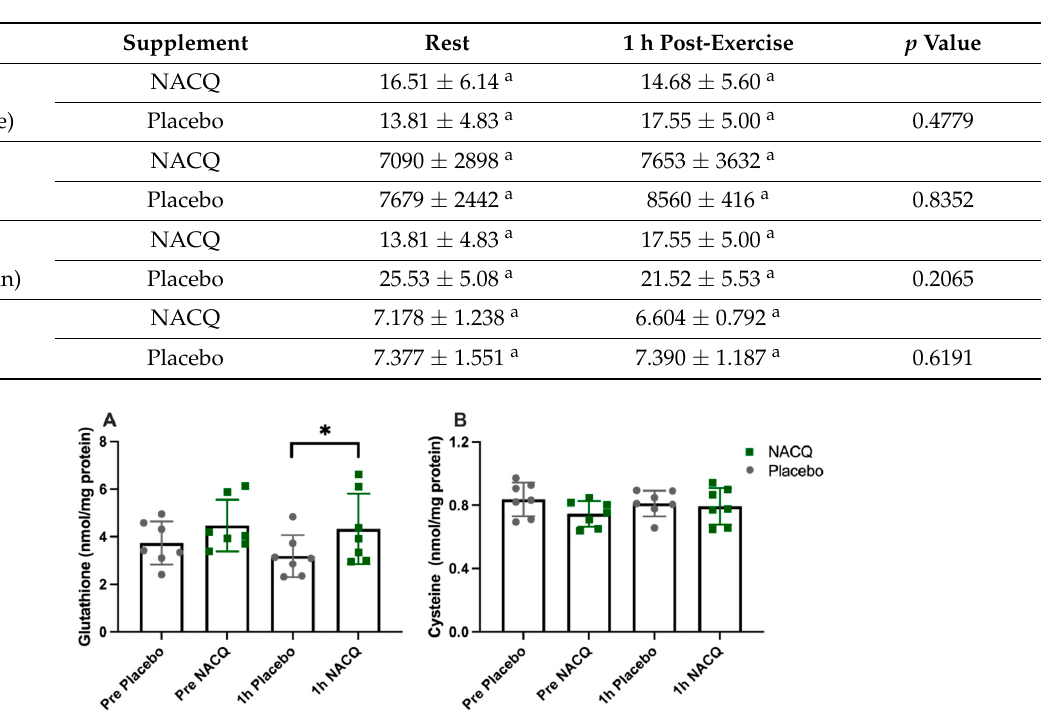
Figure 2. ( A ) Gluteal muscle glutathione concentrations in horses at rest and 1 h after exercise with NACQ (green) or placebo (grey) supplementation. The 1 h-post-exercise glutathione concentrations were significantly higher in NACQ horses than placebo ( p = 0.022). ( B ) Muscle cysteine concentrations at rest and 1 h after exercise in horses supplemented with NACQ or placebo. Concentrations